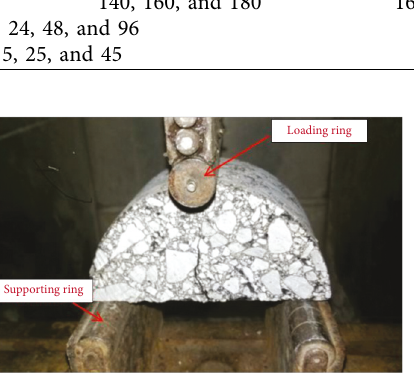
Figure 6: SCB test diagram.